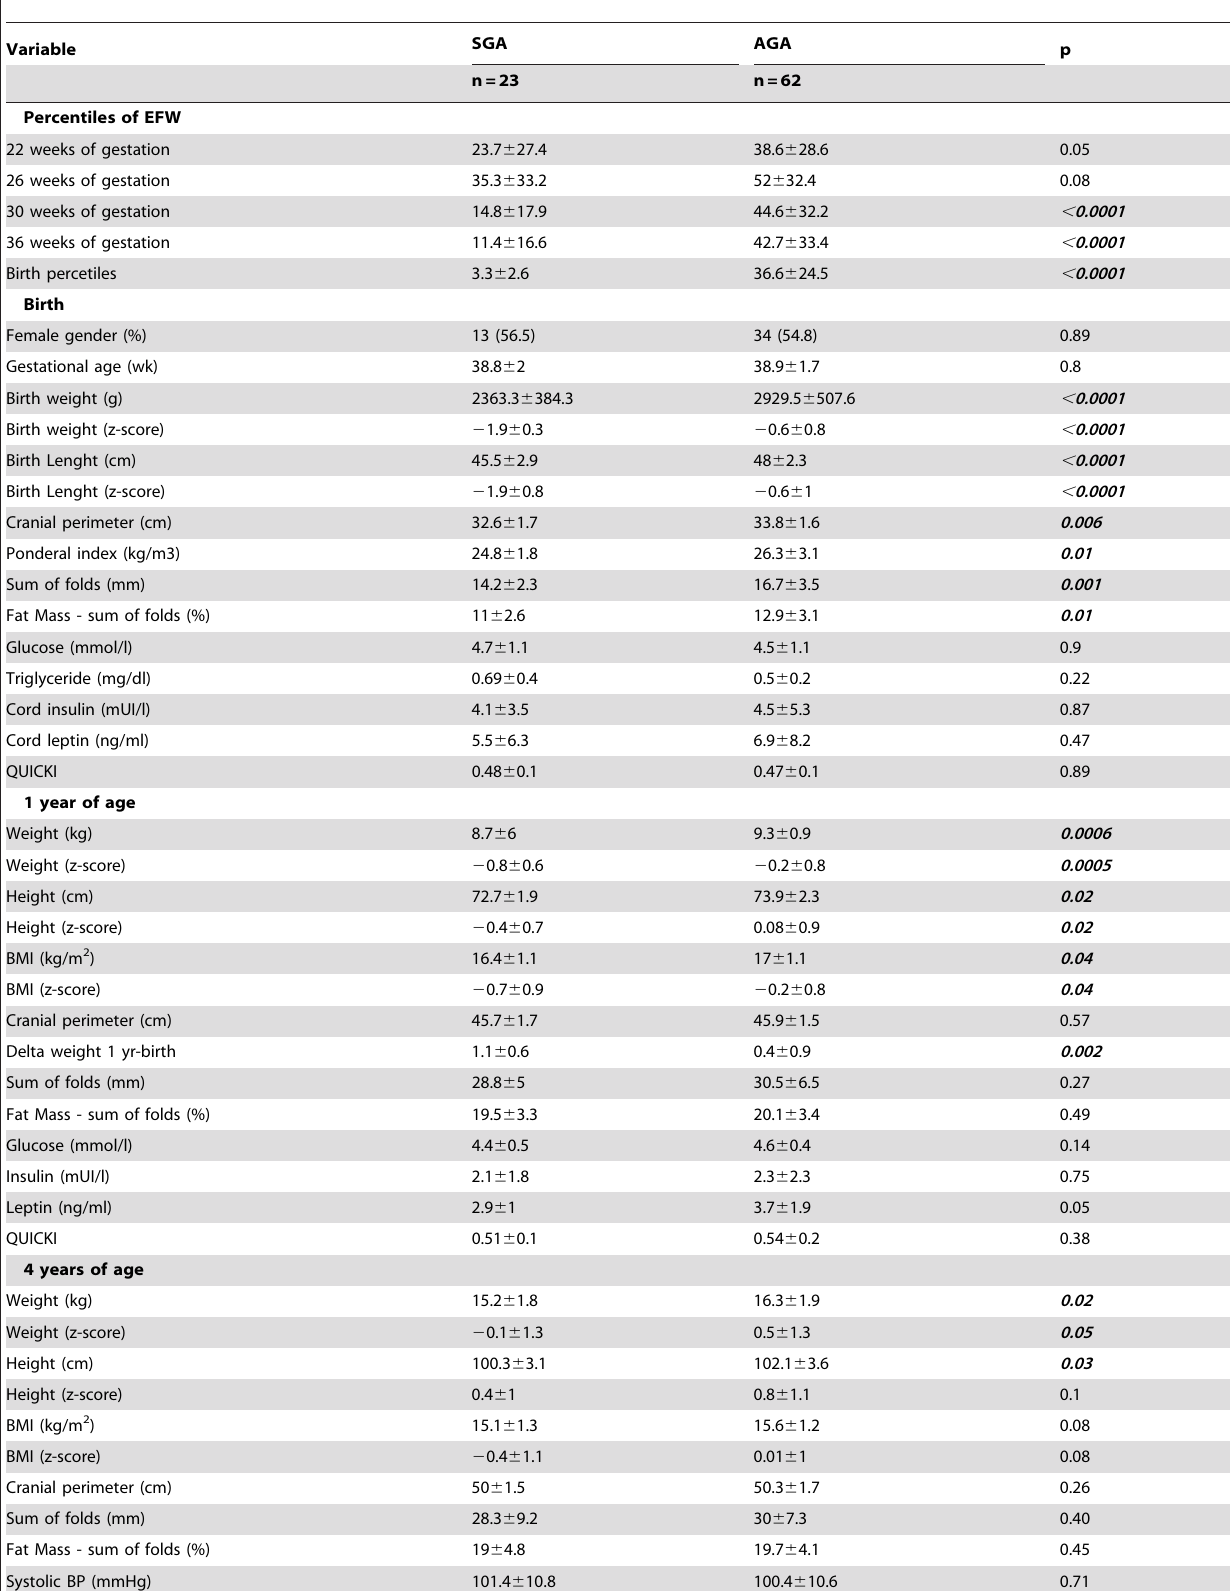
Table 1. Estimated fetal weight (EFW) from 22 weeks of pregnancy until birth and anthropometric and hormonal characteristics at birth, 1 and 4 years of life between SGA and AGA